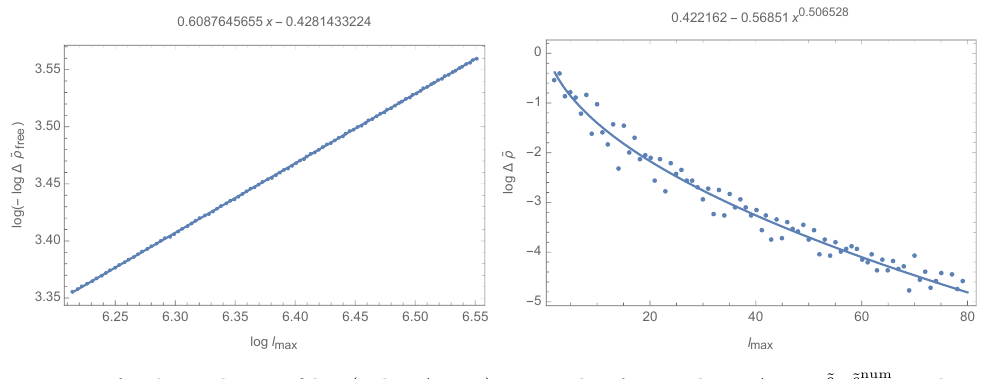
Figure 3 . Left : dependence of log ( (cid:0) log (cid:1)~ (cid:26) free ) versus log ‘ max , where (cid:1)~ (cid:26) (cid:17) ~ (cid:26) (cid:0) ~ (cid:26) num